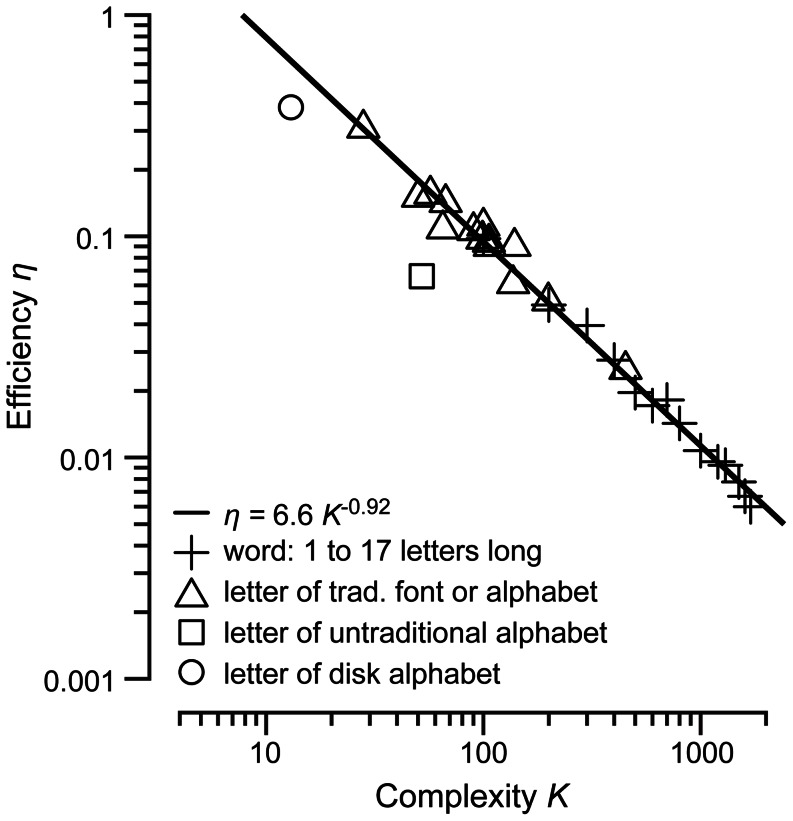
Efficiency for identifying letters and words as a function of their complexity.Efficiency is nearly inversely proportional to complexity over a nearly hundred-fold range. The horizontal scale is the perimetric complexity (perimeter squared over ink area) of the letter or word. Each+is efficiency for identifying one of 26 words of a given length (1 to 17) in Courier [24]. Each Courier letter has a complexity of 100 (averaging a-z), and the complexity of a word is proportional to its length. Each △ is efficiency for identifying one letter of one of 14 traditional fonts and alphabets by native or highly trained readers, in order of increasing complexity [25]: Braille, bold Helvetica, bold Bookman, Sloan, Helvetica, Hebrew, Devanagari, Courier, Armenian, Bookman, Arabic, uppercase Bookman, Chinese, Künstler. The outlying □ is efficiency for a letter in an untraditional alphabet: 4×4 random checkerboards, after extended training [25]. The outlying ○ is efficiency for identifying the location of a disk. (See ‘Experiment 5. Identifying disks’ at the end of Materials and Methods.) A disk has the lowest possible perimetric complexity K = 4π = 12.6. A linear regression of log efficiency vs. log complexity for the traditional letters (13 fonts and alphabets) and words (13 lengths), excluding the untraditional alphabet and disk, has a slope of −0.92 and R
2 = 0.99. The regression line and its equation are shown.